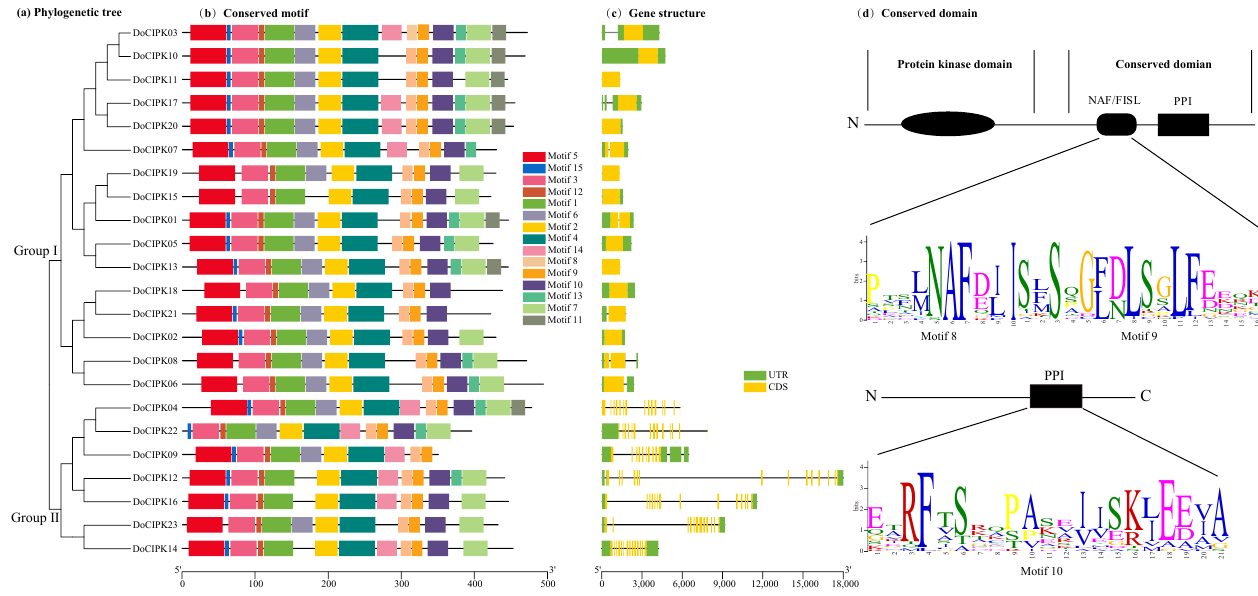
Figure 5. Phylogenetic tree of DoCIPK proteins ( a ), motif distribution ( b ), gene structure ( c ) and conserved domains and motifs ( d